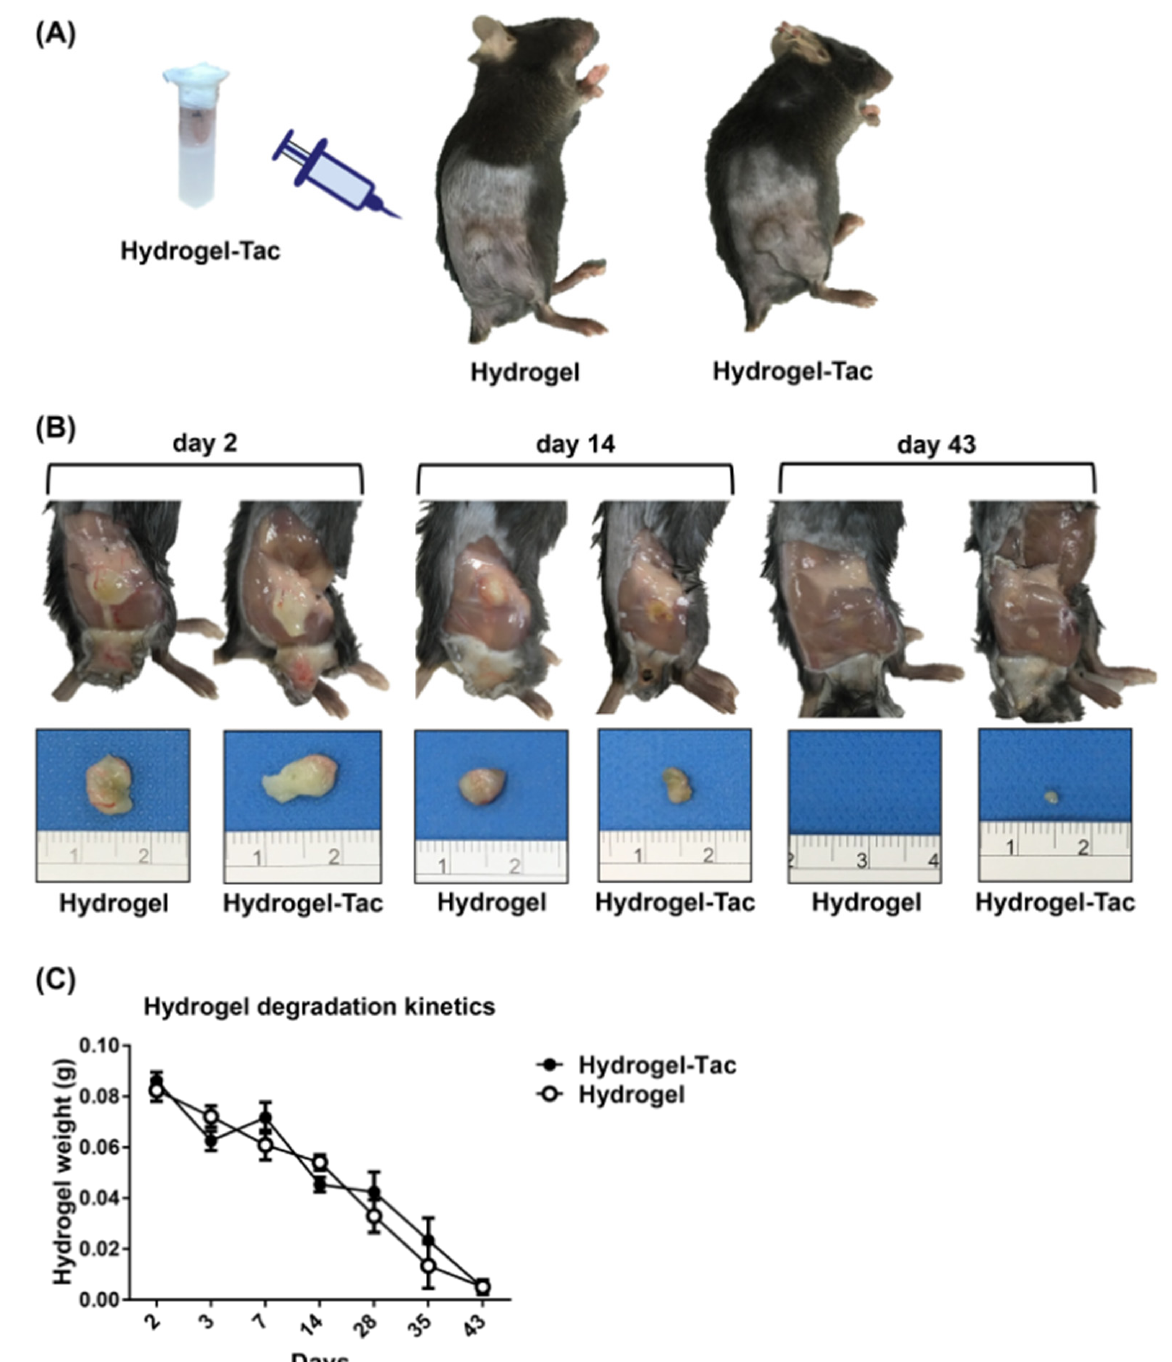
Figure 1. The degradation kinetics of hydrogel in the mouse model. ( A ) 2 mg of tacrolimus was encapsulated in 1 mL of polypeptide thermosensitive hydrogel, forming 2 mg/mL of Hydrogel-Tac. Subsequently, 0.1 mL of Hydrogel-Tac or hydrogel was injected into the subcutaneous space of the hindlimb, which was near the transected sciatic nerve. ( B , C ) The hydrogels with or without tacrolimus were harvested at different time points from the mice injected with one dose of 0.1 mL of hydrogel or Hydrogel-Tac (2 mg/mL) and then weighed. The smallest unit of measurement was a millimeter. Each group had three mice. Mean ± SD was used to represent the statistical data.